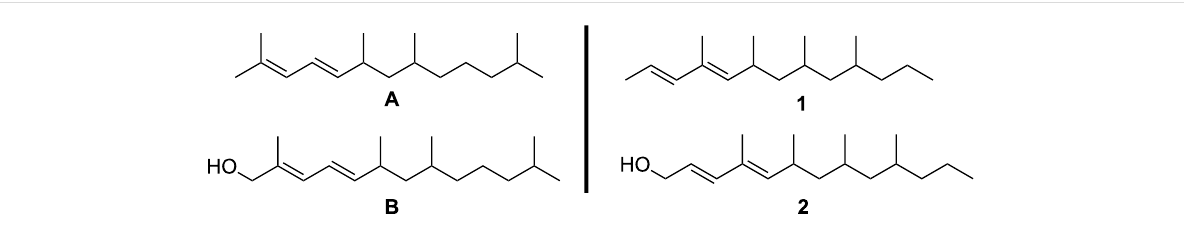
Figure 1: Originally proposed structures A and B and revised structures 1 and 2 of putative sex pheromone components of Trichogramma turkestanica .